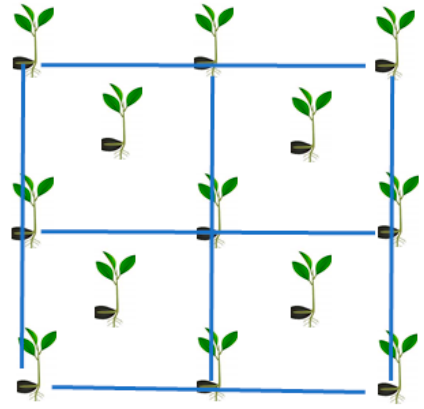
Figure 5. Quincunx pattern of planting.